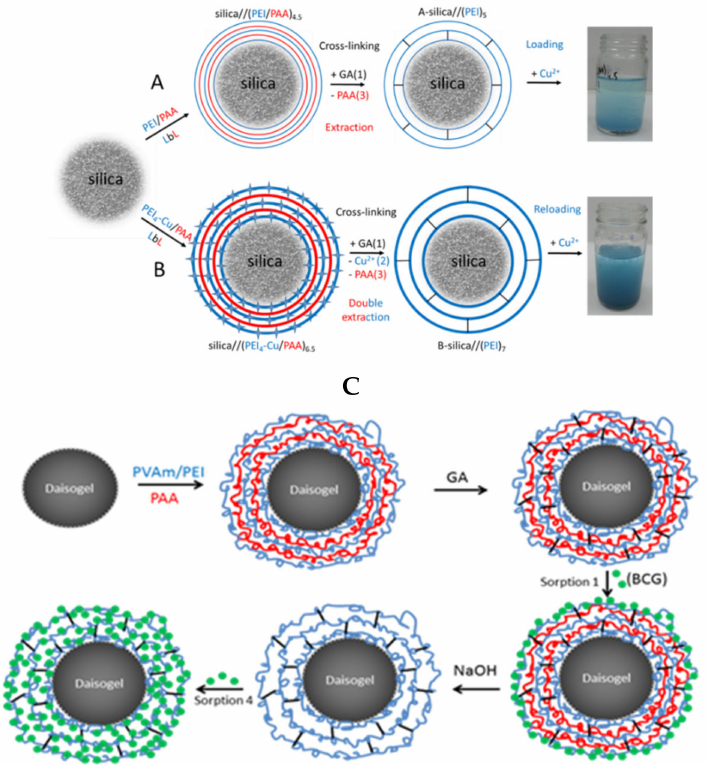
Figure 9. Schematic representation of LbL strategies to obtain silica//(polyelectrolyte) n with high capacities in removal of Cu 2+ ( A , B ) (reprinted with permission from ref. [101]) and dyes ( C ) (reprinted with permission from ref. [109]) from aqueous